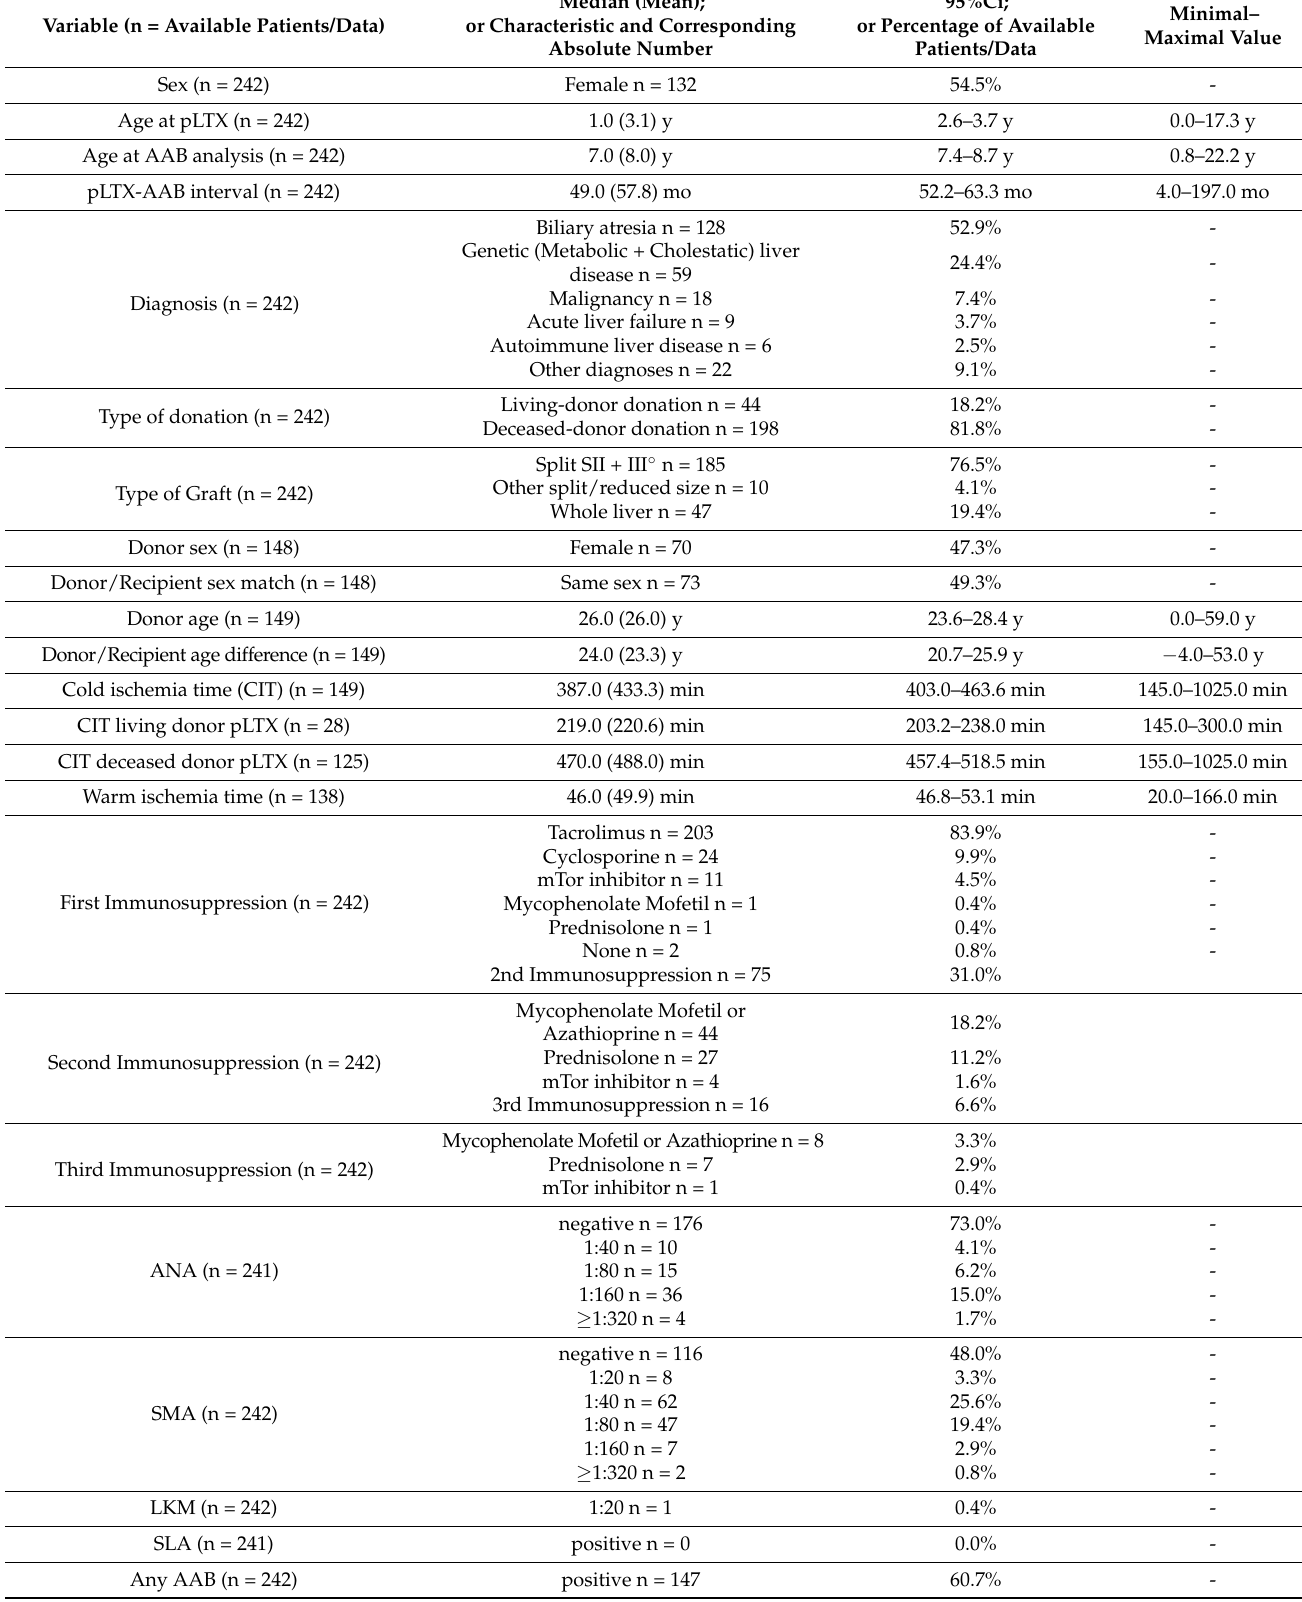
Table 1. Baseline characteristics of total cohort (n =